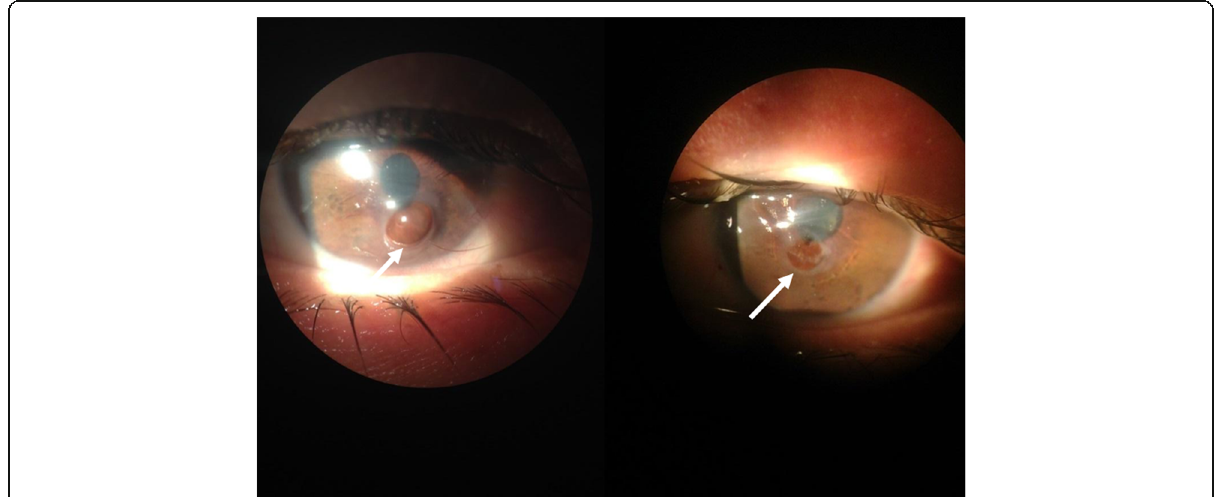
Fig. 3 Ocular involvement in GPA. Bilateral corneal ulcers, in OD inferior-paracentral located (white arrow) with iris exposure and in OS centrally located (white arrow) with iris exposure, mild corneal edema, and athalamia